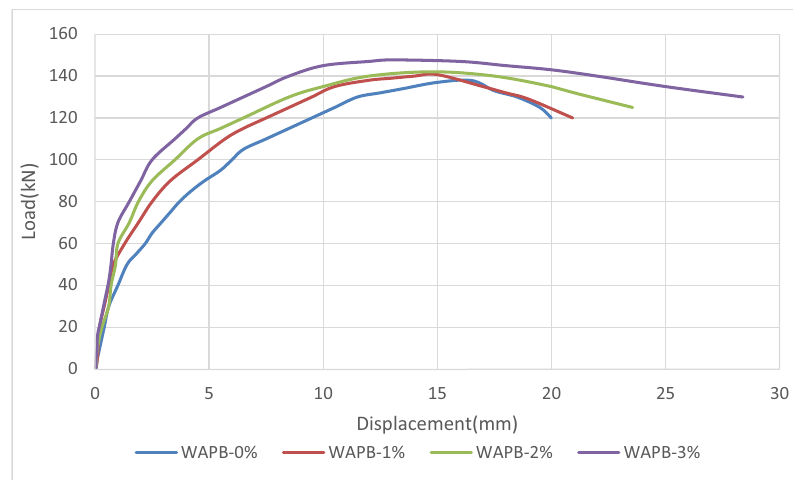
Figure 3: E ff ect of the WAPB volume ratio on the load - de fl ection